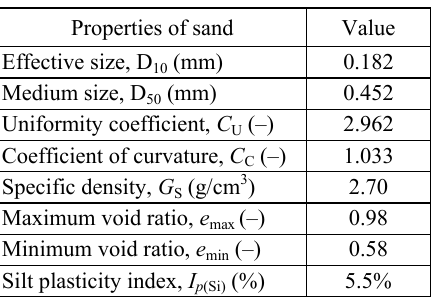
Table 1. Summary of basic Chlef sand physical properties